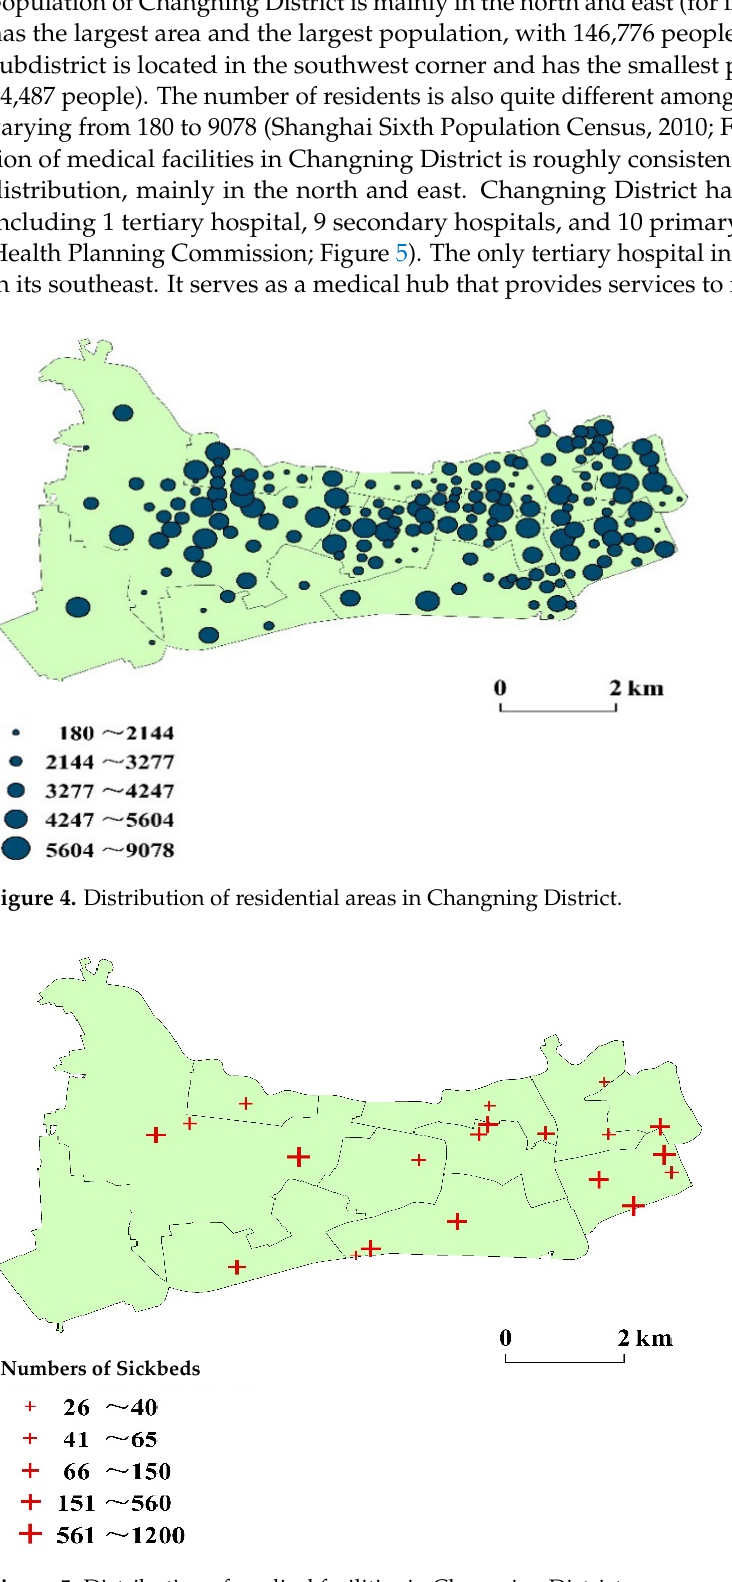
Figure 3. Overview of the study area.